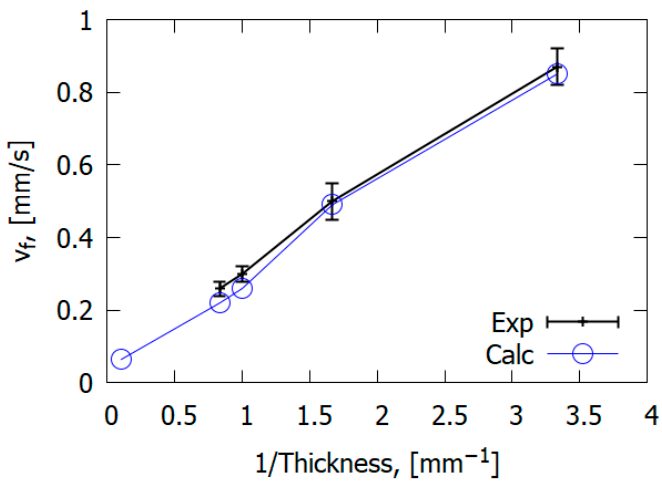
Figure 22. Dependence of the ROS over GFRER slabs on slab thickness. Exp—experiment; Calc—calculation.